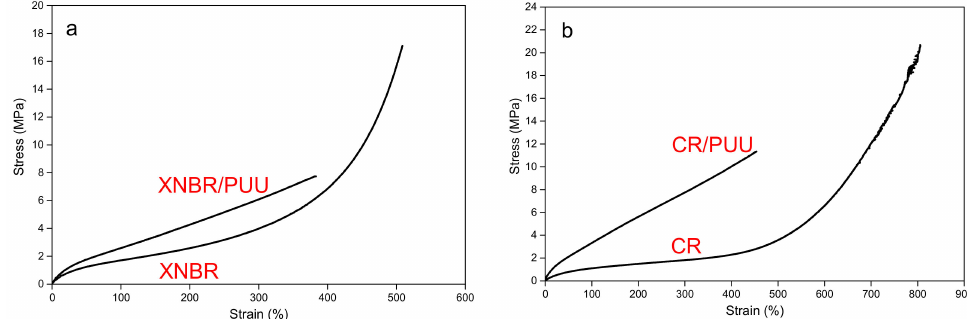
Figure 3. Stress–strain plots of vulcanizates: ( a ) XNBR and XNBR/PUU; and ( b ) CR and